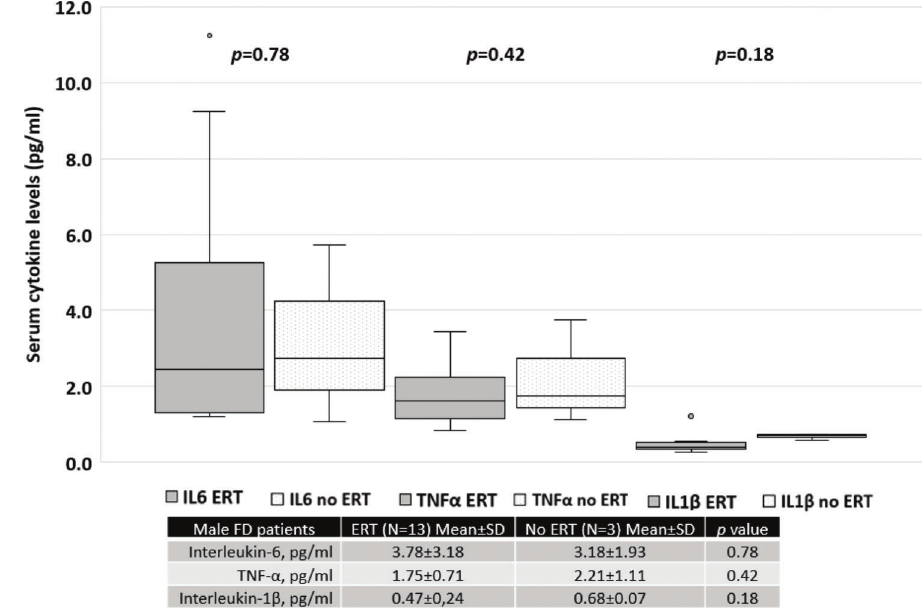
Figure S2 - Serum cytokine levels in men with FD treated with ERT versus those not treated with